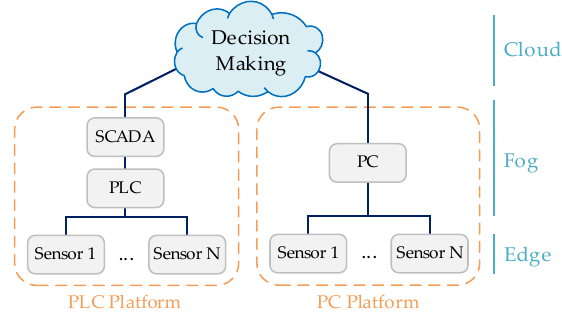
Figure 1. Intelligent sensors in a Cloud to Fog to Edge architecture.